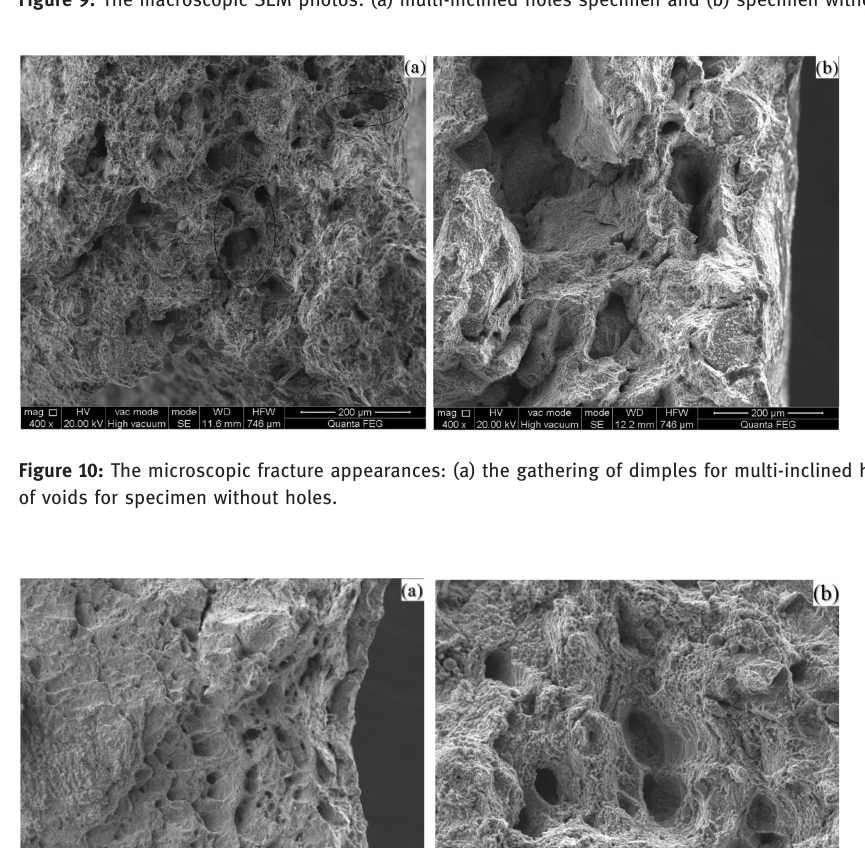
Figure 9: The macroscopic SEM photos: (a) multi-inclined holes specimen and (b) specimen without holes.